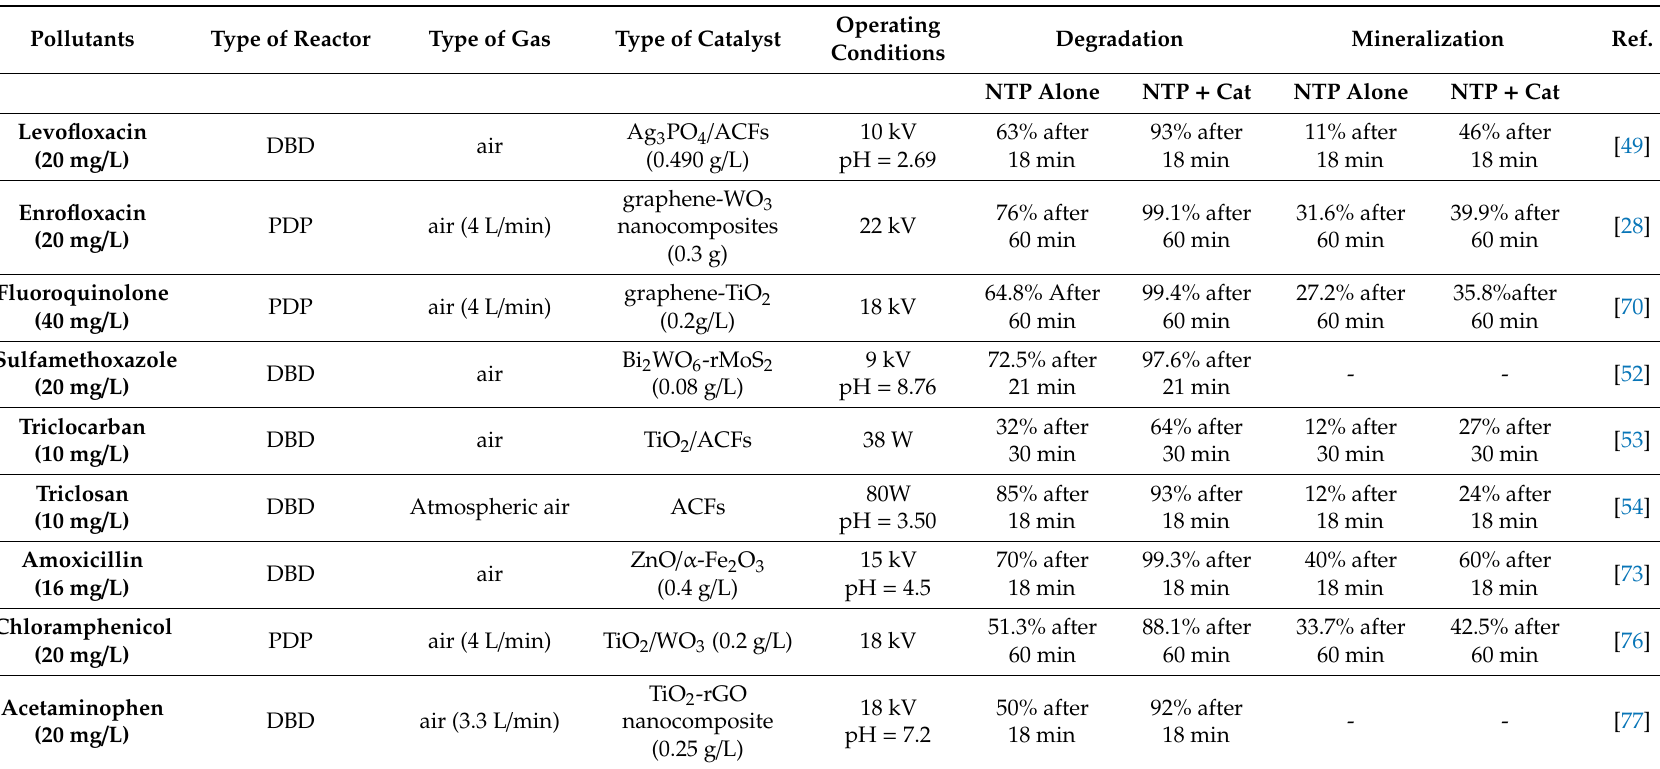
Table 1. Summary of main operating condition and catalyst used for the degradation and mineralization of emerging contaminants in aqueous phase by NTP coupled with